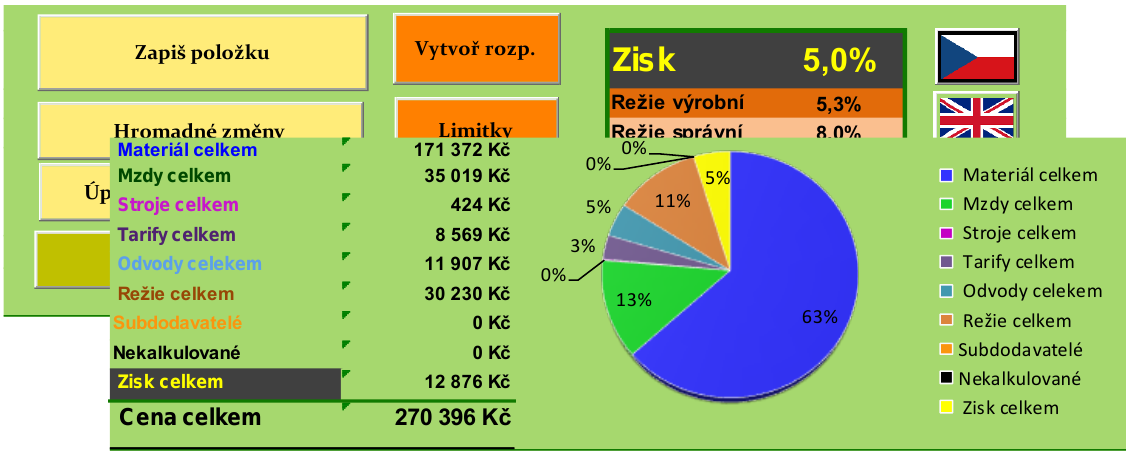
Figure 4: Části ovládací lišty aplikace (zdroj: autor)